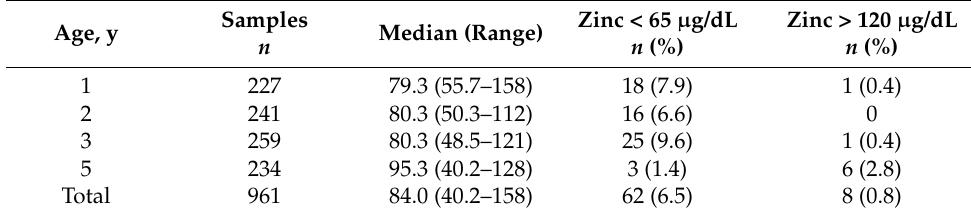
Table 2. Serum zinc status throughout the first 5